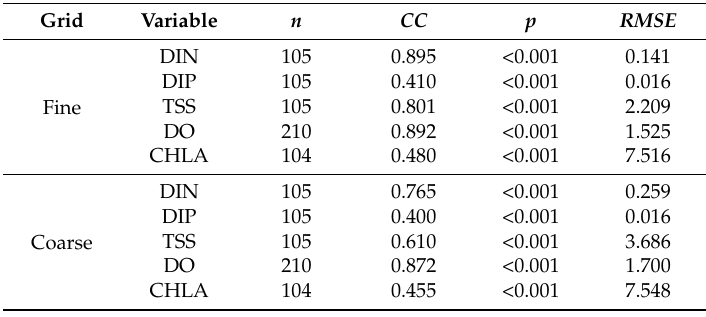
Figure 3. Time series of observed (open dots) and simulated (black solid line, fine ‐ grid results; red dash line, coarse ‐ grid results) water quality and phytoplankton state variables at three sampling sites in Chesapeake Bay (Figure 1) in 2010: NH4 (ammonia), NO23 (nitrite and nitrate), PO4 (phosphate), TSS (total suspended solids), DO (dissolved oxygen) and CHLA (chlorophyll ‐ a). Table 3. Model observation statistics with two sets of model grids in 2010.